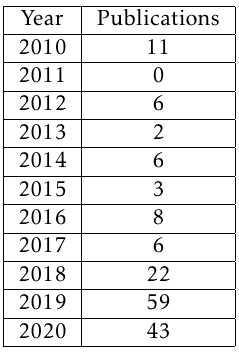
Table 3. Publications per year in sciencedirect